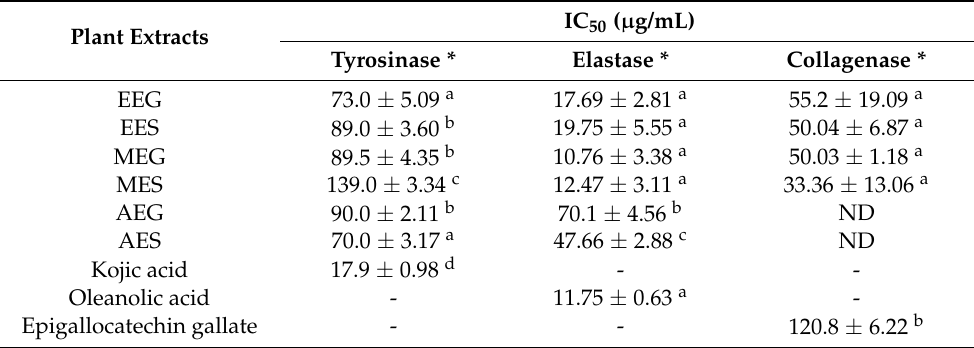
Table 1. Inhibition of the aqueous (AE), ethanolic (EE), and methanolic (ME) extracts from W. filifera collected in the areas of Sousse (S) and Gab è s (G), expressed as IC 50 values ( µ g/mL). Standard compounds are kojic acid, oleanolic acid, and epigallocatechin gallate for tyrosinase, elastase, and collagenase, respectively. IC 50 ( µ g/mL) Plant Extracts Tyrosinase